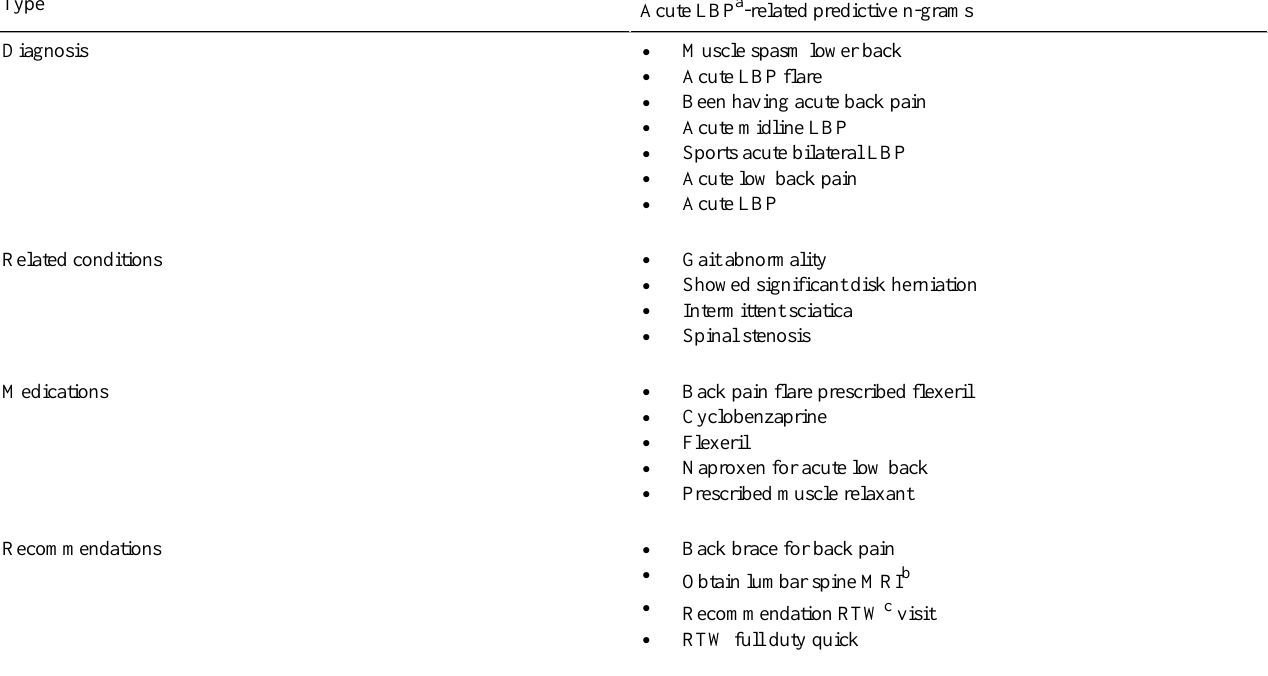
Table 2. Examples of n-grams that were relevant in identifying acute low back pain notes when using convolutional neural network-based architecture trained with manual annotations. The n-grams’relevance was determined by analyzing the neurons of the convolutional neural networks activating the max-pooling layers and their log-odds to contribute to the final output. Log-odds were filtered per notes and then averaged over all the notes and evaluation